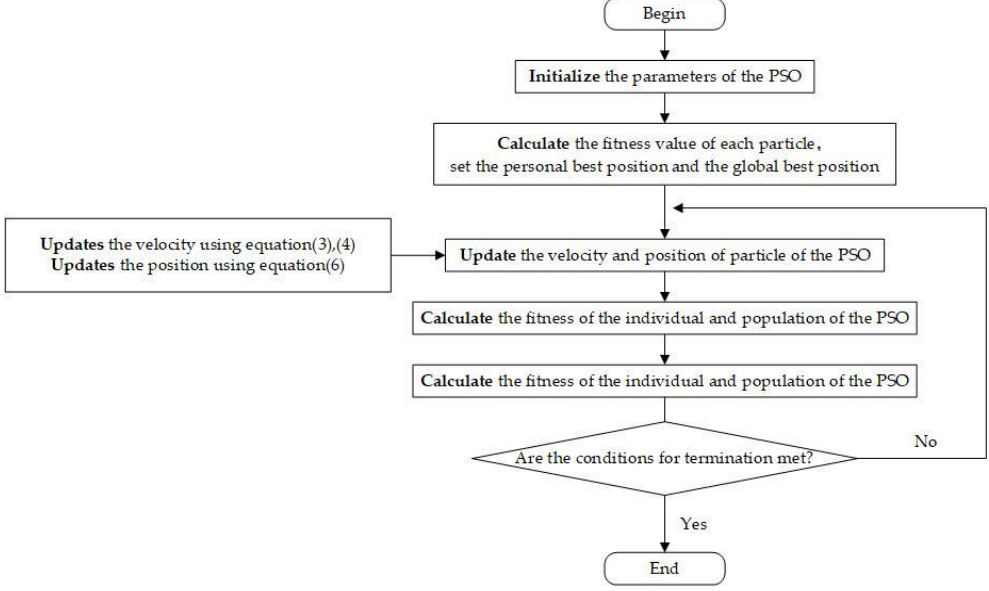
Figure 2. The flow of the APSO/DU.